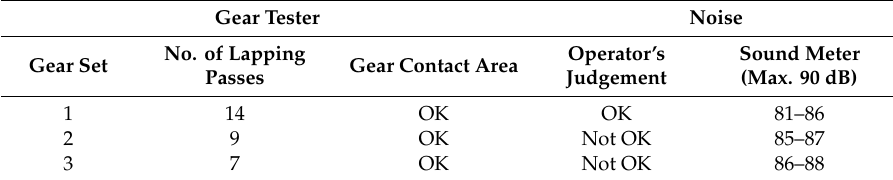
Table 2. E ff ect of Lapping passes on Noise